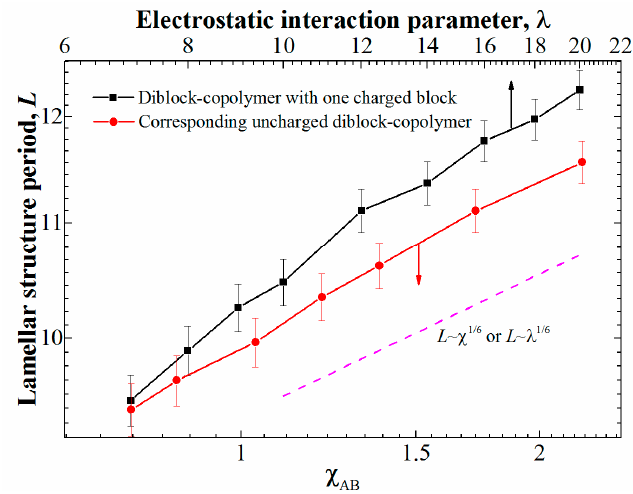
Figure 2. The period of the lamellar structure for ϕ = 0.5 depending on the interaction parameter: λ for the diblock-copolymers with a charged block and χ AB for the corresponding neutral diblock-copolymers. The ranges of the X-axes are chosen so that they show the same relative increase of the interaction